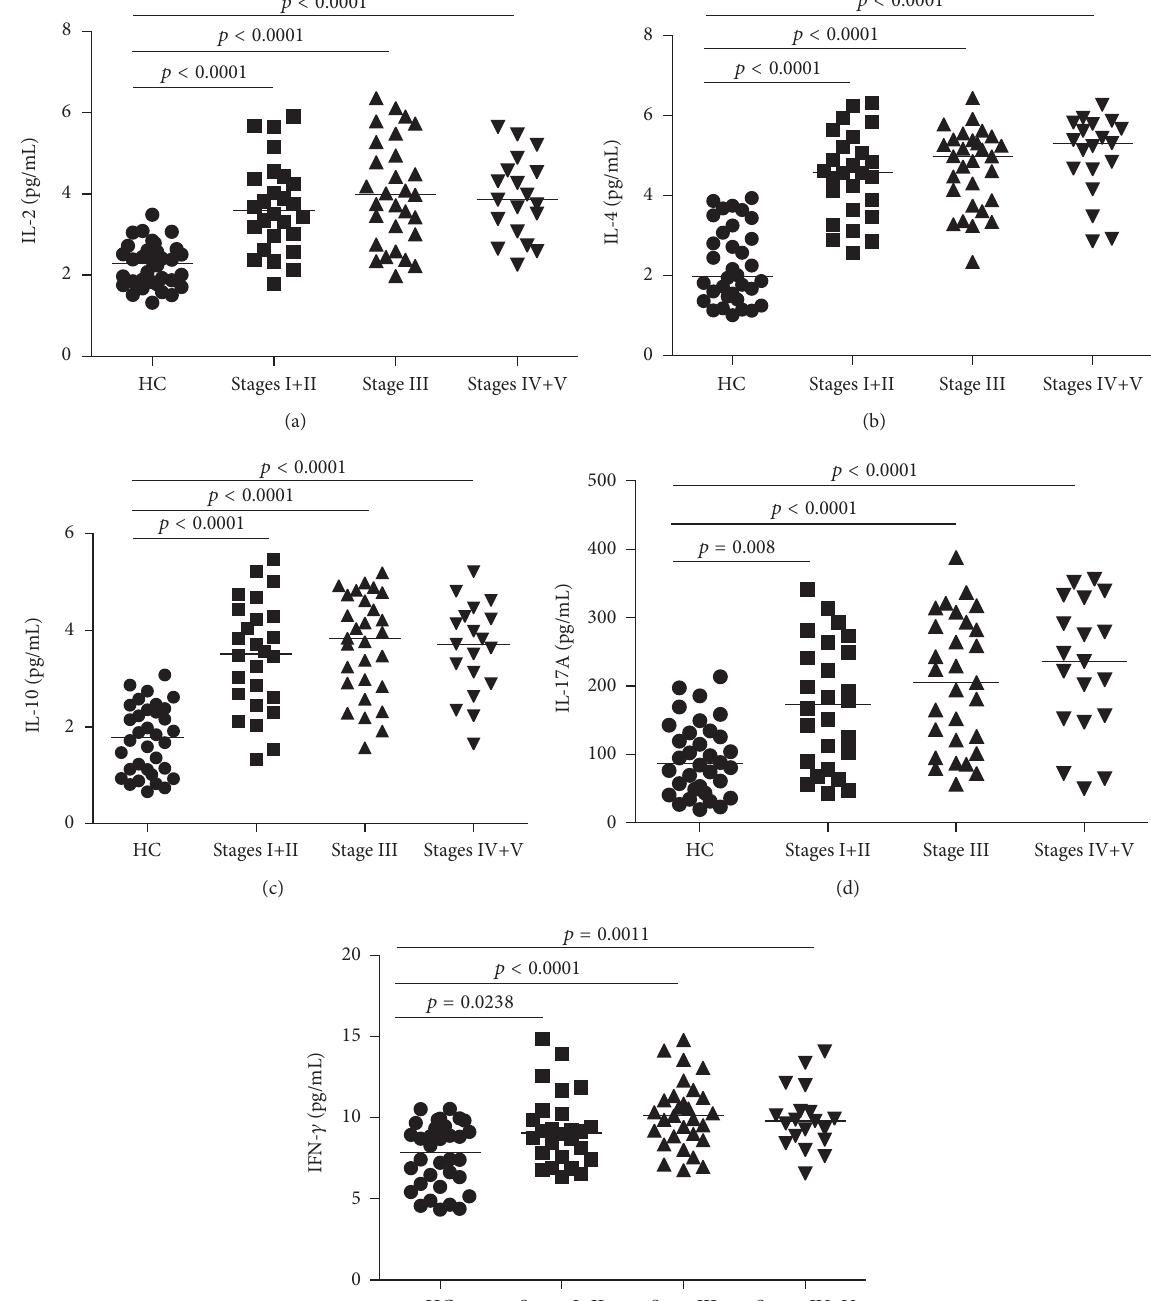
Figure 4: Increased serum levels of IL-2, IL-4, IL-10, IL-17A, and IFN- 𝛾 in IgAN patients before treatment. CBA was used to detect the levels of sera IL-2, IL-4, IL-17A, IL-10, and IFN- 𝛾 ((a)–(e), resp.) in IgAN patients and HCs. Data are expressed as mean values of individual samples from two divided experiments. Horizontal lines represent median values of different